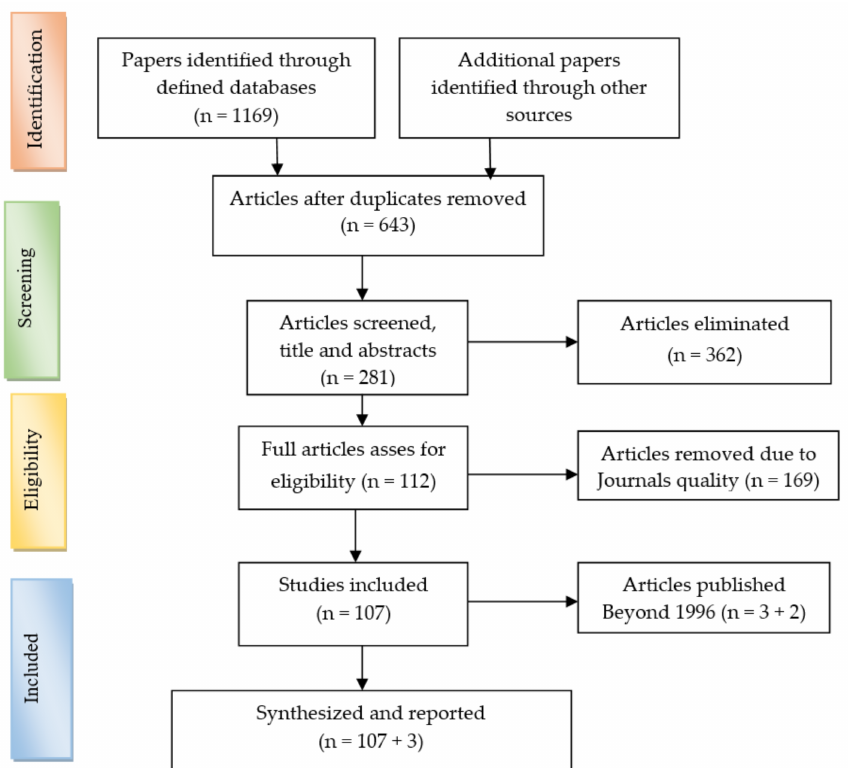
Figure 1. The search-appraisal-synthesis